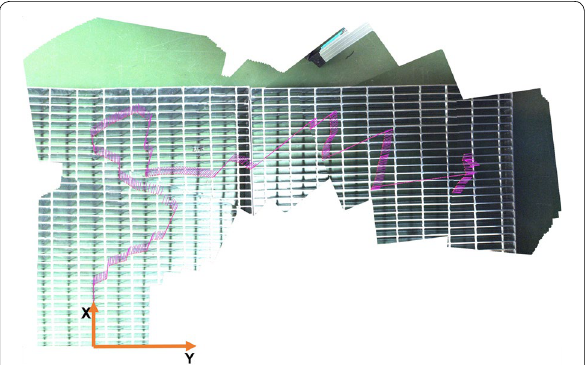
Fig. 10 One of the maps generated by the visual odometry method (the purple lines indicate the instant camera poses, forming a jagged shape when rotating; the vectors form the overall camera trajectory)